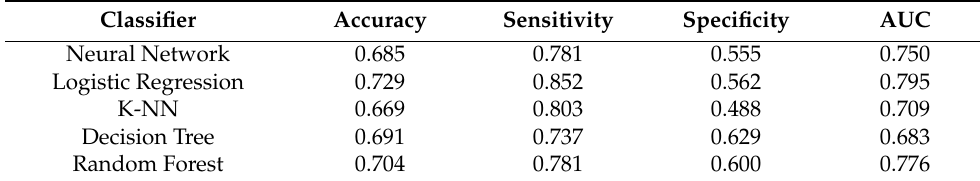
Table 2. Performance comparison based on accuracy and AUC.